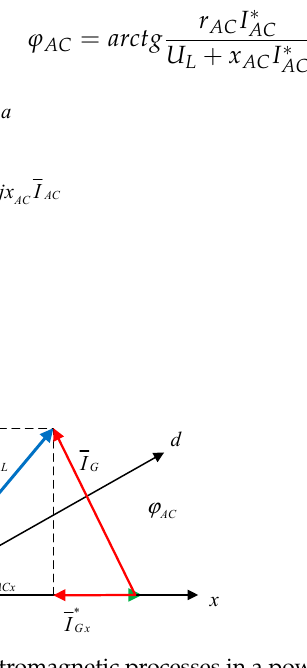
Figure 6. Vector diagram of electromagnetic processes in a power generator. (red vectors—refer to PMSG, blue vectors—refer to load, green vectors—refer to AC)